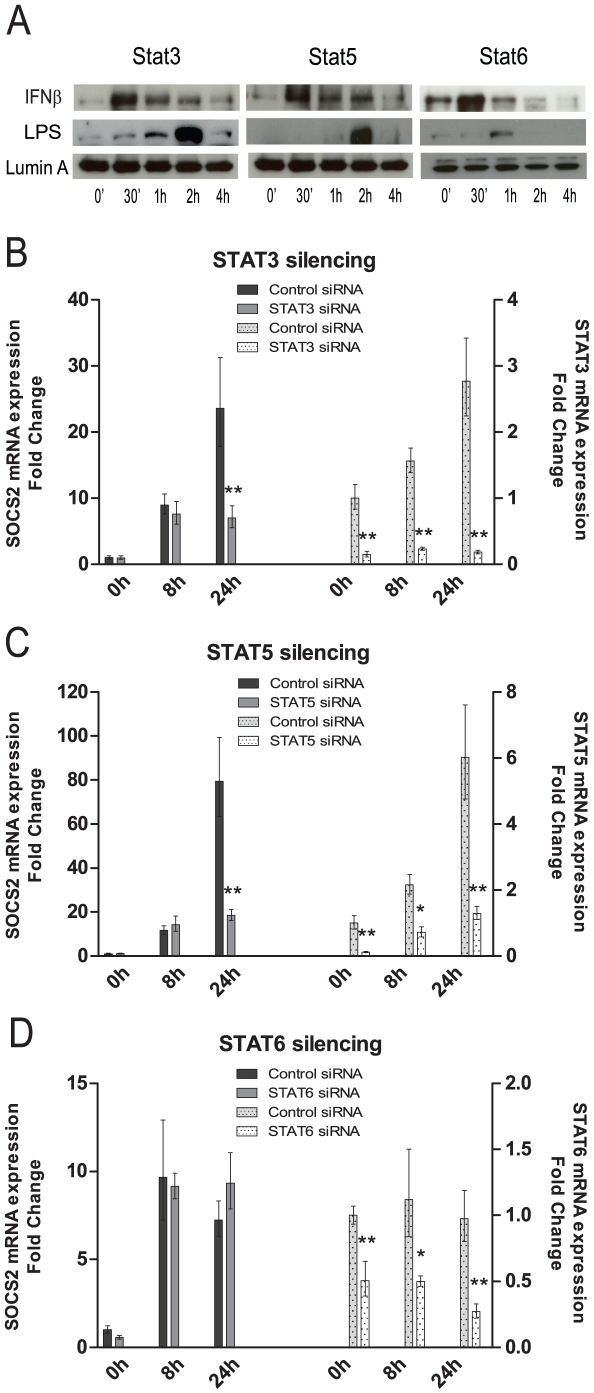
STAT3 and STAT5, but not STAT6 are required for SOCS2 mRNA induction in human moDCs.(A) STAT3 and STAT5, but not STAT6 were translocated into the nucleus after IFNβ or LPS stimulation. moDCs were incubated with IFNβ or LPS at the indicated time points. The cells were then harvested and nuclear proteins were extracted for Western Blotting measurement. The levels of STAT3, STAT5, STAT6 and LaminA (as loading control) were detected. (B, C and D) STAT3 and STAT5, but not STAT6 gene silencing eliminates SOCS2 mRNA induction in TLR4 signaling. moDCs were transfected with (B) STAT3, (C) STAT5 or (D) STAT6 siRNAs or control siRNA and incubated for 24 hours. The transfected cells were exposed to LPS for 0 h, 8 h and 24 h, the cells were then harvested for the mRNA measurement by qRT-PCR to demonstrate the effect of SOCS2 mRNA induction (left) and efficiency of target gene silencing (right). Data shown are representative of three independent experiments and expressed as the –fold induction of the gene of interest at different time points compared to time point 0 for control siRNA where values were set to 1. Significance comparing results from the target siRNA to the control siRNA group is indicated (* p<0.05; ** p<0.01).